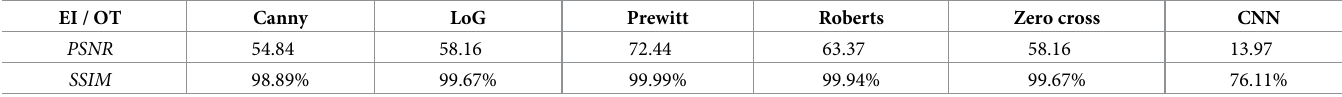
Table 6. A comparison of edge detection methods using EMDS-5. Evaluation index (EI), Operator type